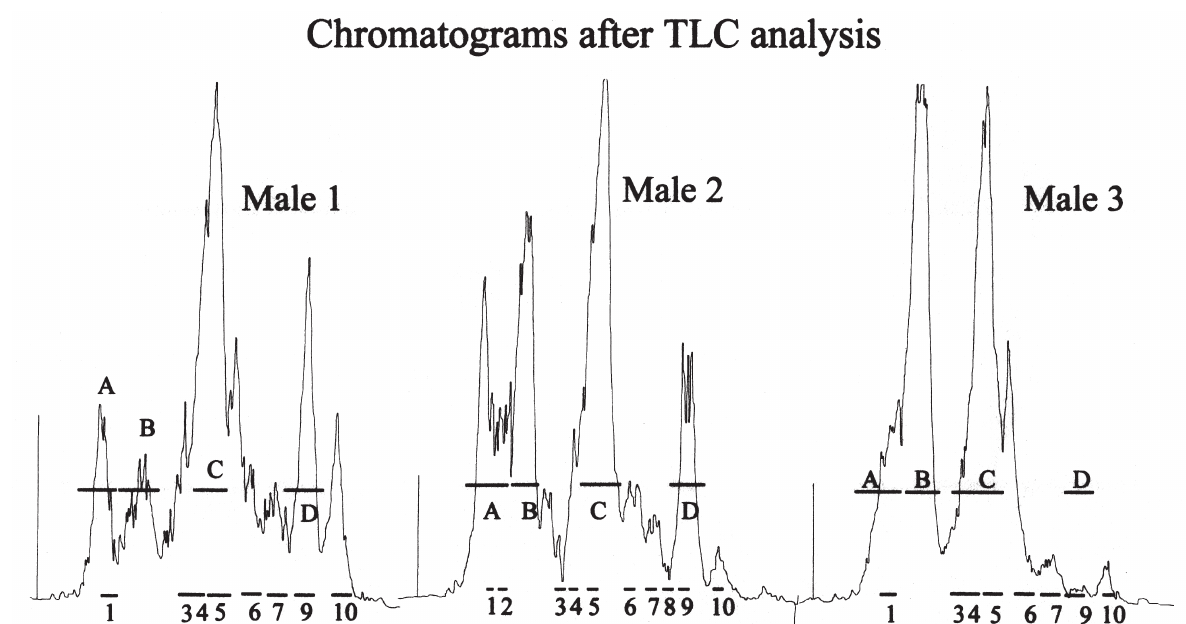
Fig. 1. Radiochromatogram after TLC analysis of spermiating testes of Micropogonias furnieri males 1, 2 and 3 after toluene/cyclohexane 50/50 v/v (system I) and benzene/acetone 80/20 v/v (system II). The TLC zones further analyzed by HPLC are shown as A, B and C. The peak of precursor is shown as D. The authentic standards used were: 1 = 20-dihydrocortisone; 2 = 17,20,21-P; 3 = 17,20α-P; 4 = 11KT; 5 = 17,20ß-P; 6 = 11ßOH-A; 7 = Ad; 8 = testosterone; 9 = 17-P; 10 =